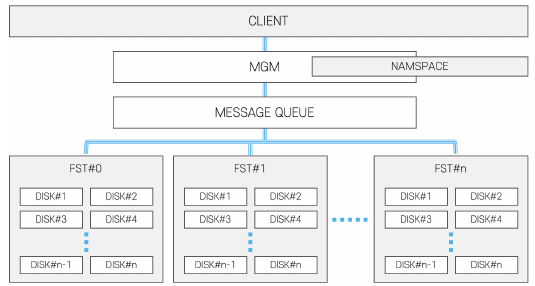
Figure 2. Structure of